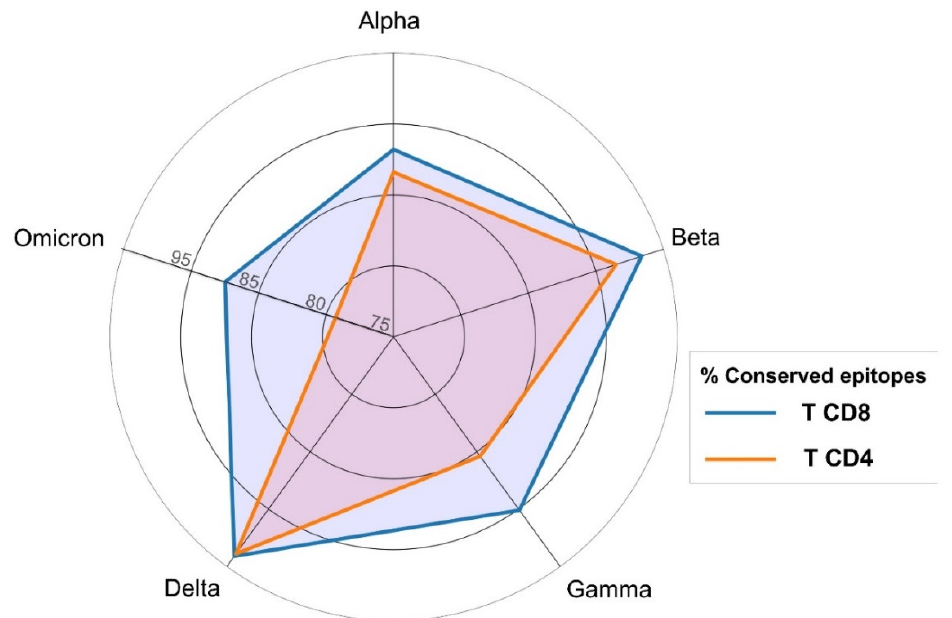
Figure 5. CD8 and CD4 T cell epitopes conservation in SARS-CoV-2 variants of concern (VOCs). Percentage of T cell epitopes (CD8 in blue and CD4 in orange) not affected by mutations in SARS-CoV-2 VOCs.